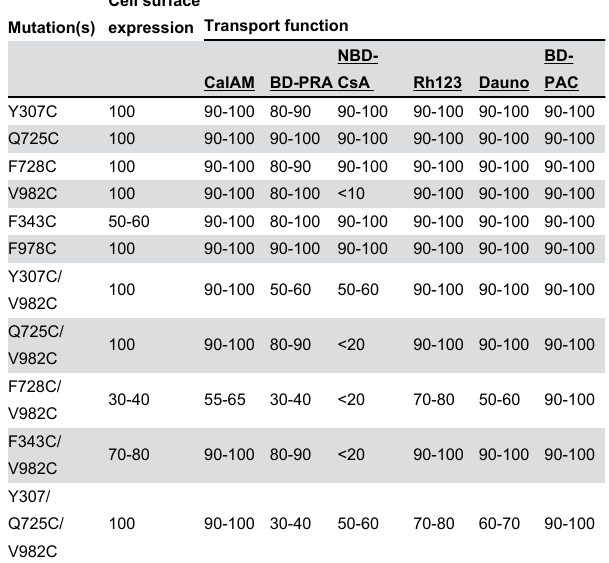
Table 2. The mutant Pgps expressed in HeLa cells exhibit normal cell surface expression but variable steady-state level of transport of different